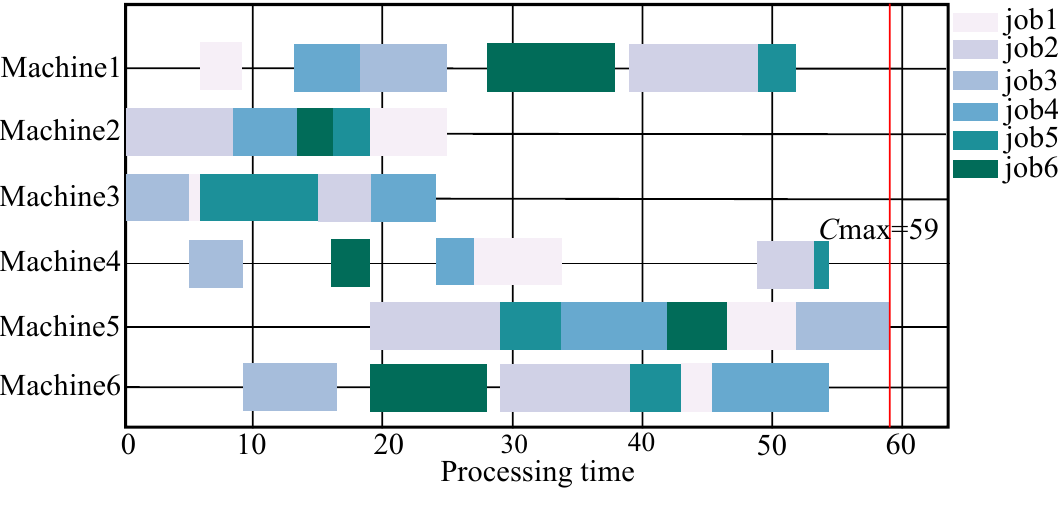
Figure 5. The Gantt chart of FT06.